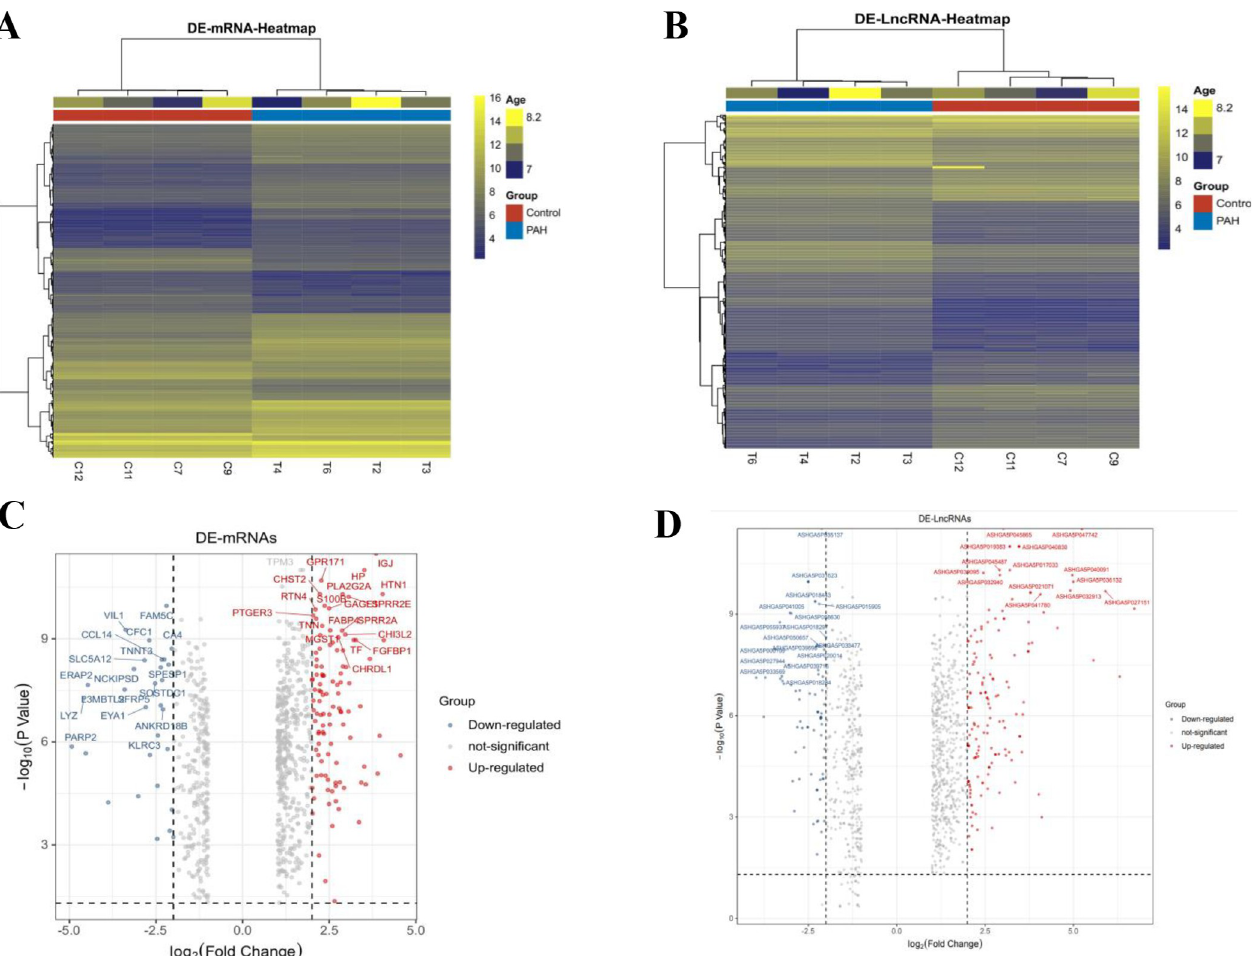
Fig 1. Differentially expressed profiles of mRNAs and lncRNAs in the PAH groups compared to the control groups using gene microarray analysis. (A) The hierarchical clustering of differentially expressed mRNAs. n = 4. (B) The hierarchical clustering of differentially expressed lncRNAs; n = 4. (C) Volcano plots representing the variations of mRNAs. (D) Volcano plots representing the variations of lncRNAs.fold change > 2, P <